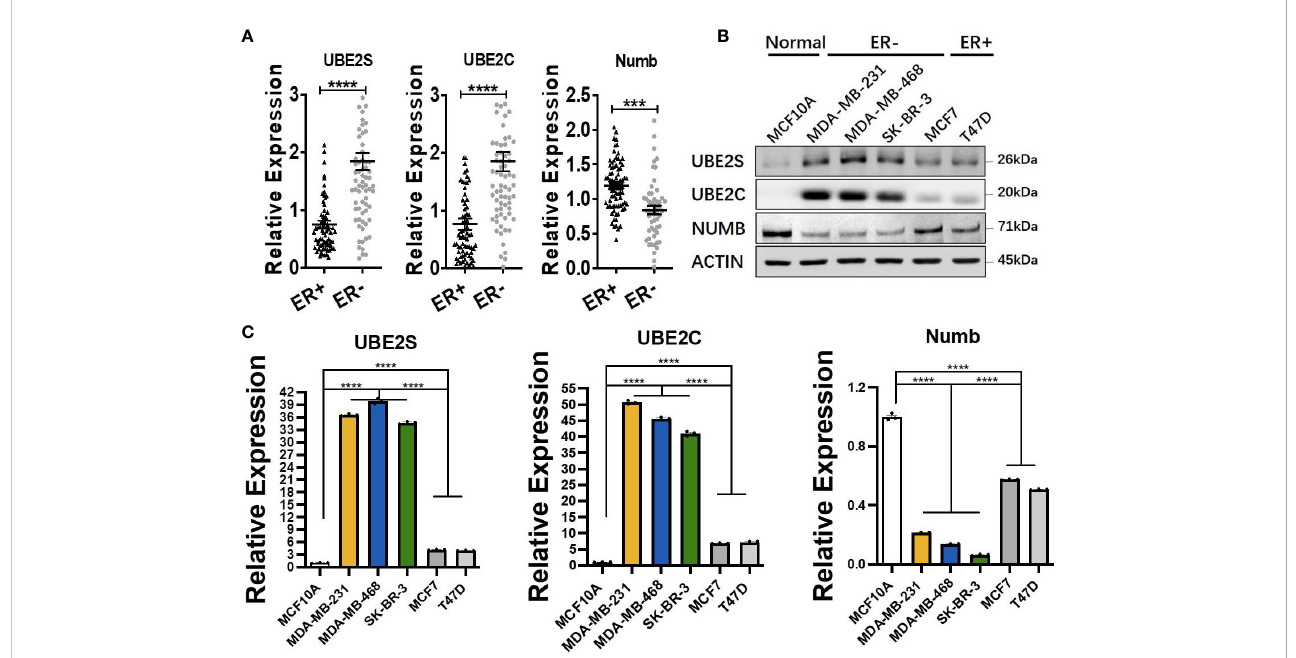
FIGURE 4 Comparison of UBE2S, UBE2C, and Numb between ER+ and ER − breast tumors. (A) The mRNA levels in ER+ and ER − breast tumors (ER+ n = 70, ER − n = 74). ER − breast cancer shows higher levels of UBE2S and UBE2C, as well as lower Numb expression. (B) Western blot for protein levels and (C) qRT- PCR for mRNA levels in breast cell lines. One normal breast epithelial cell line (MCF10A), three ER − breast cancer cell lines (MDA-MB-231, MDA-MB-468, and SK-BR-3), and two ER+ breast cancer cell lines (MCF7 and T47D) a re adopted. Breast cancer cell lines demonstrate higher UBE2S and UBE2C and lower Numb than normal controls. ER − breast cancer cell lines show higher UBE2S and UBE2C, as well as lower Numb expression, than ER+ breast cancer cell lines. Student ’ s t -test was used for the statistical analysis. ***, P < 0.001; ****, P <